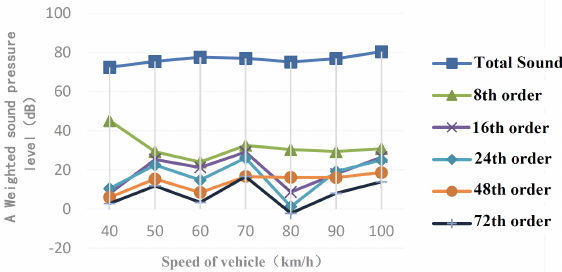
Fig. 9. Noise order analysis of driver's external ear (constant driving speed condition).